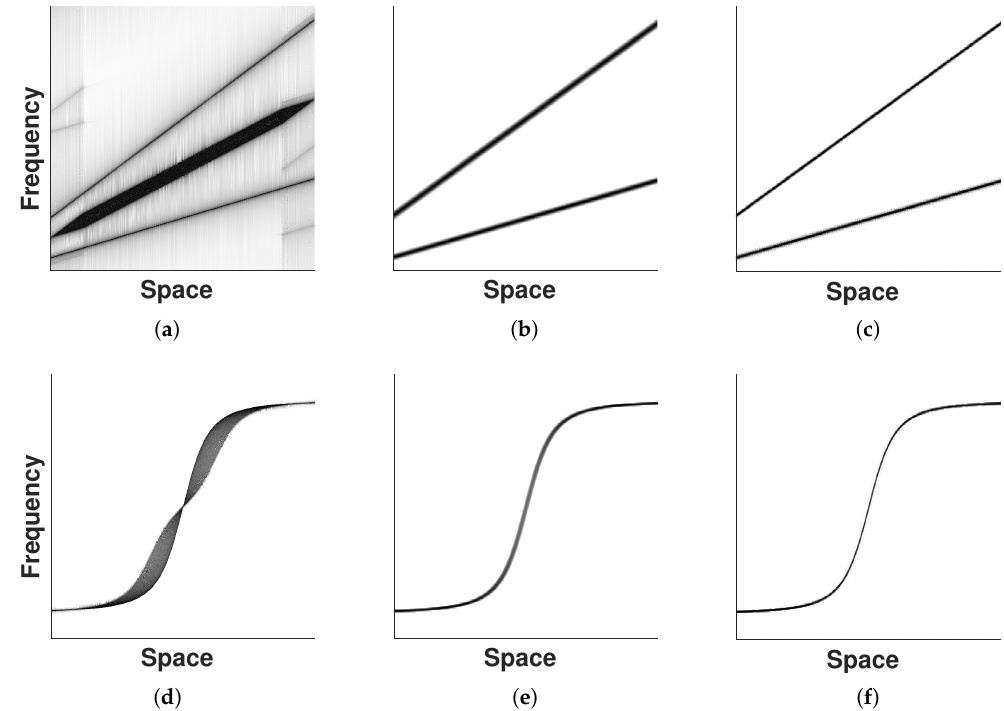
Figure 4. Comparison of phase space representations evaluated on two examples of wavefronts expanding along z illustrate the arising interference terms—2 × parabolic (top); 1 × spherical (bottom). ( a ) Wigner–Ville; ( b ) spectrogram; ( c ) S-method; ( d ) Wigner–Ville; ( e ) spectrogram; ( f )